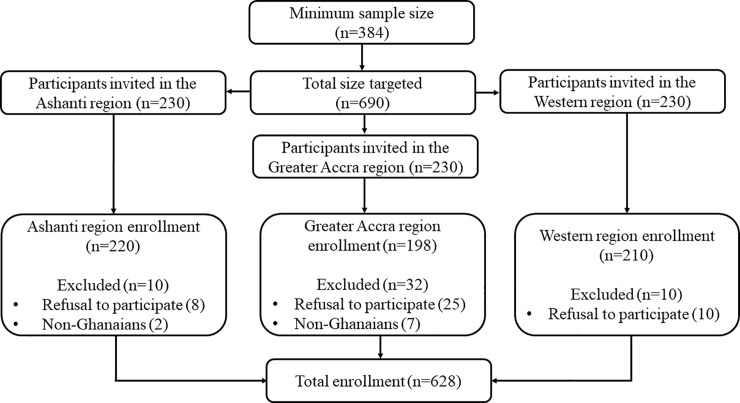
Flowchart showing selection of study participants.